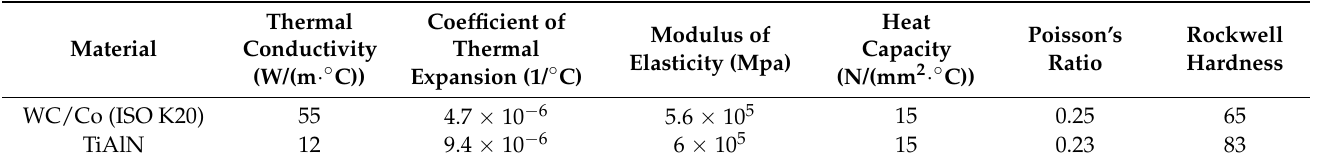
Table 2. Material parameters of the micro-milling cutter.